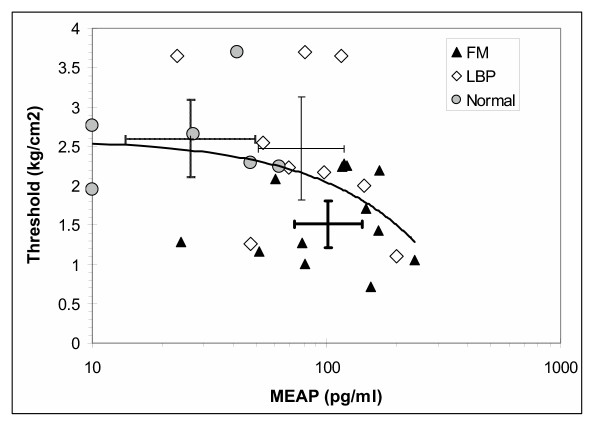
Semi-logarithmic relationships between pain thresholds and MEAP. FM subjects (black triangles) had pain thresholds below 2.3 kg/cm2 (heavy, black error bars). Normal subjects (grey circles, cabled grey error bars) had lower MEAP and higher pain thresholds compared to FM. LBP subjects (open diamonds) had results that covered the full ranges for both variables (upper right error bars). The data for all subjects were linearly correlated (Pearson's correlation coefficient R = -0.38, p < 0.05) with an explained variance (R2) of 0.15. The line appears curved on this semi-logarithmic plot.